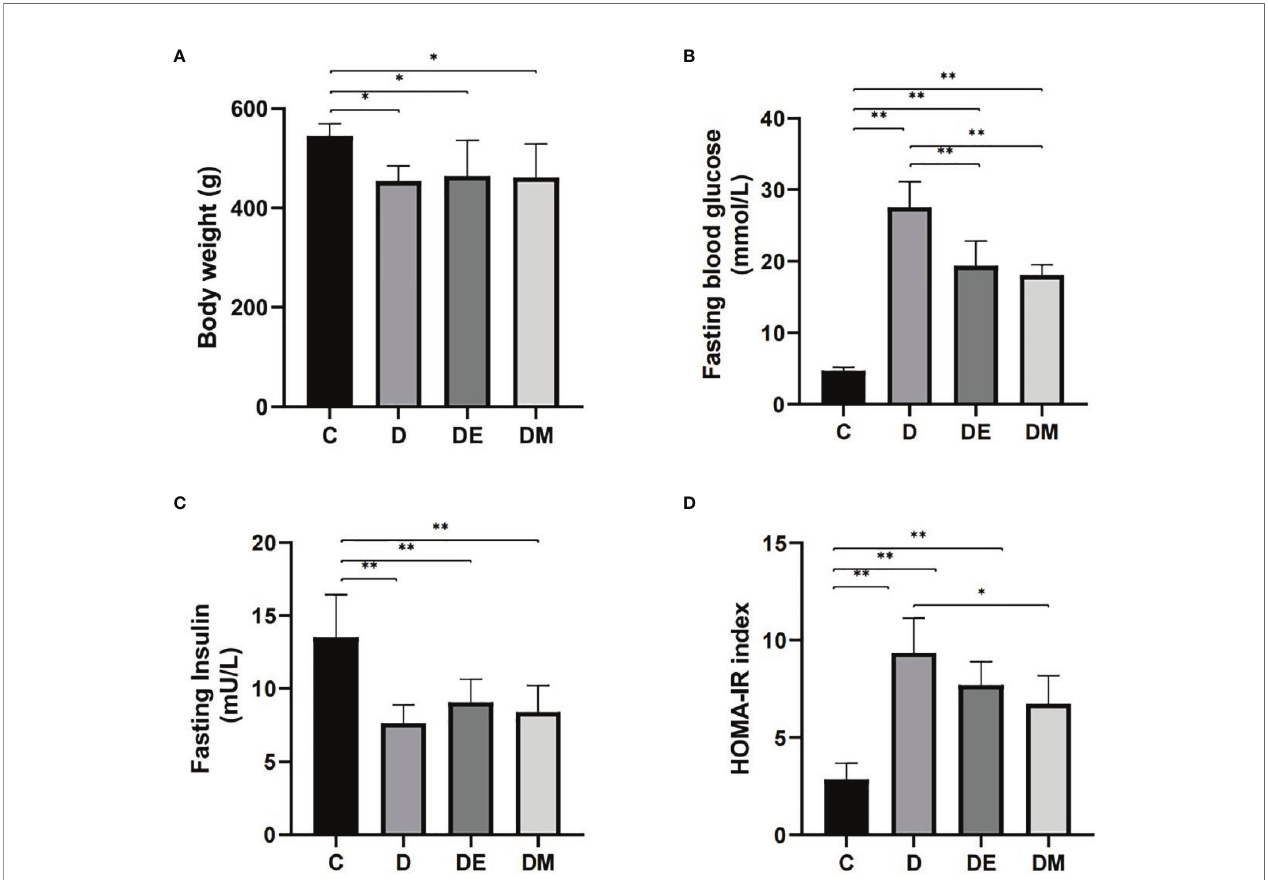
FIGURE 1 | Body weights, fasting blood glucose, fasting insulin, and HOMA-IR after 8 weeks of aerobic exercise and MOTS-c treatment. (A) Body weights were higher in rats from group DE than in group DM (p < 0.05). (B) Values for FBG in DE and DM were signi fi cantly lower than in group D (p < 0.01). (C) Rats from groups D, DE and DM groups had lower FINS compared with rats from group C (p < 0.01). (D) Values for HOMA-IR in group DM were signi fi cantly lower than in group D (p < 0.05). n = 10 rats per group; *p < 0.05, **p < 0.01; C (control), D (diabetic), DE (diabetic+ exercise), DM (diabetic +